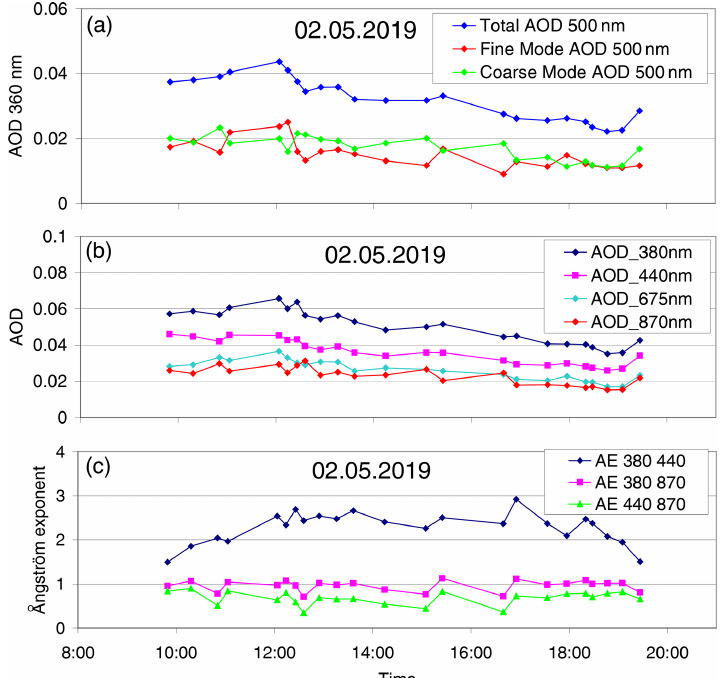
Figure A3. (a) AOD at 500nm attributed to the coarse and fine modes, as well as total AOD. (b) Total AOD at different wavelengths. (c) Ångström exponents for selected wavelength pairs.